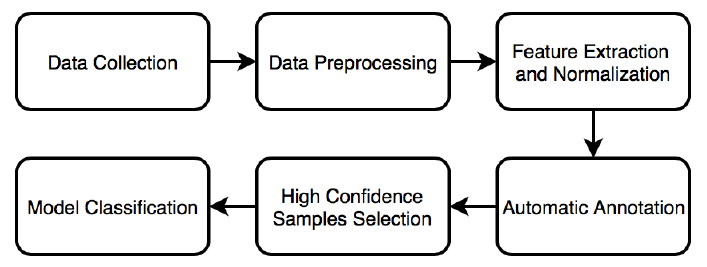
Figure 1. The process of establishing our proposed user-adaptive algorithm.